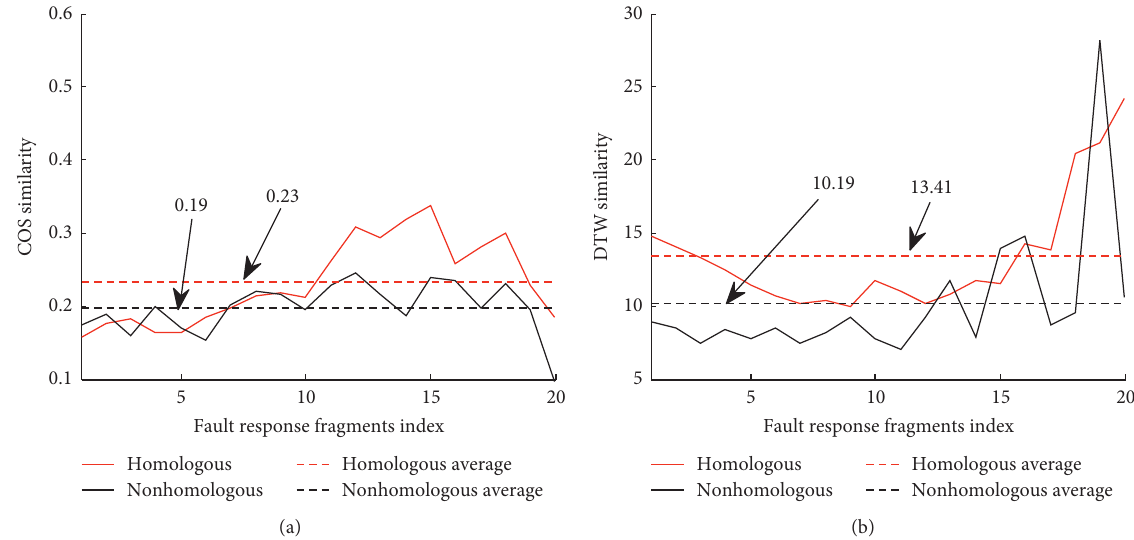
Figure 9: The simulation result of similarity calculated by comparison methods. (a) The similarity results by OT (b) The similarity result by DTW.